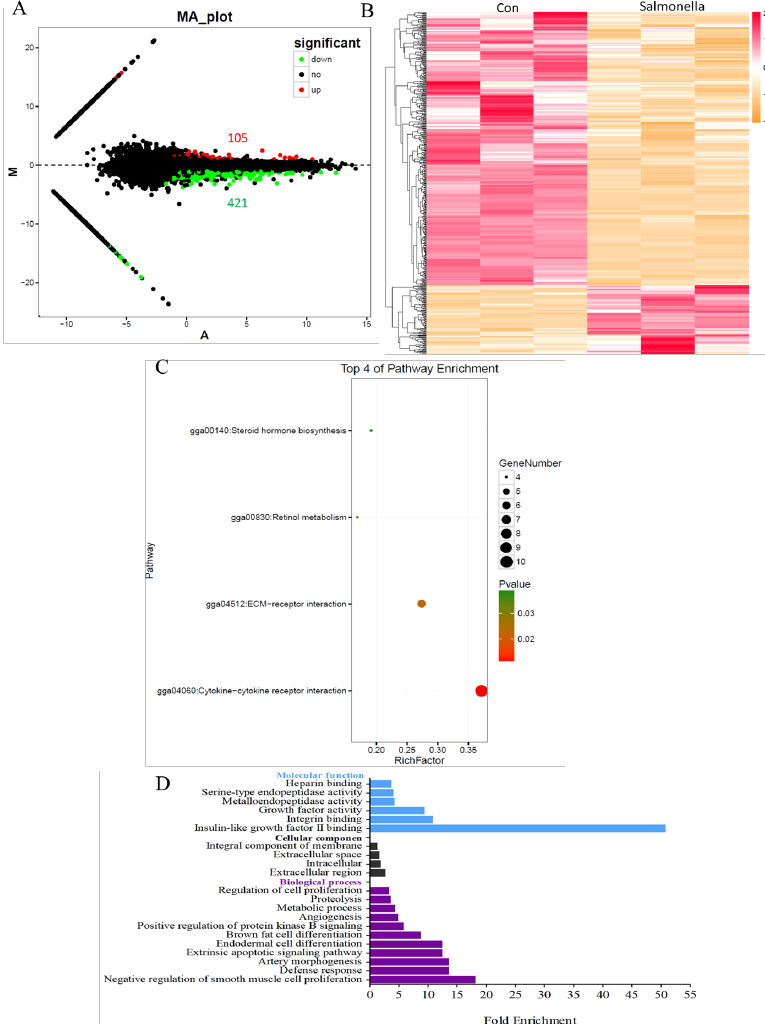
Figure 2. Defense response, extrinsic apoptotic signaling pathway, and metabolic process were affected by salmonella. ( A ) Number of DEGs between the control group (Con) and the group infected with Salmonella Pullorum C79-13 (BC), with 105 up-regulated genes and 421 down-regulated genes following salmonella infection. ( B ) Expression profiles of DEGs between the control group (Con) and the group infected with S. Pullorum C79-13 (BC). ( C ) Major over-represented GO terms of differentially expressed genes between the control group (Con) and the group infected with S. Pullorum C79-13 (BC). ( D ) Top four pathway enrichments of differentially expressed genes between the control group (Con) and the group infected with S. Pullorum C79-13 (BC).